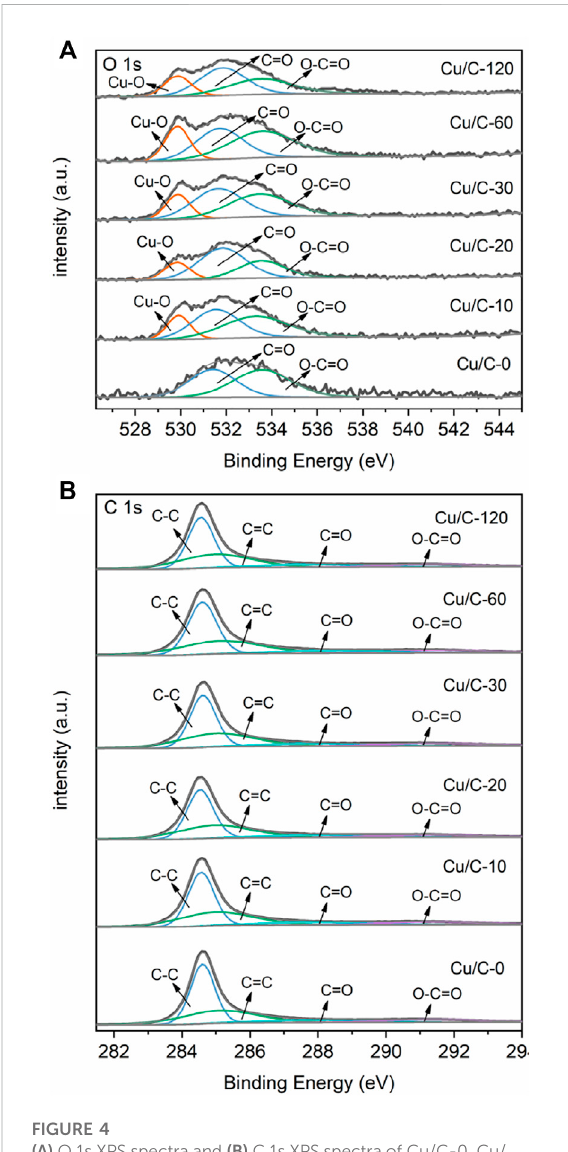
FIGURE 4 (A) O 1s XPS spectra and (B) C 1s XPS spectra of Cu/C-0,